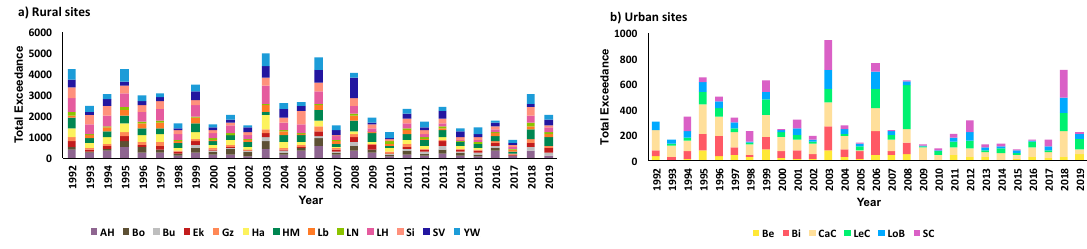
Figure 3. Yearly total exceedances of ozone in ( a ) rural and ( b ) urban sites over the last 30 years. Note that the total exceedance is the total number of hours the ozone concentration exceeded the 50 ppbv limit for ( a ) rural sites and ( b ) urban sites.